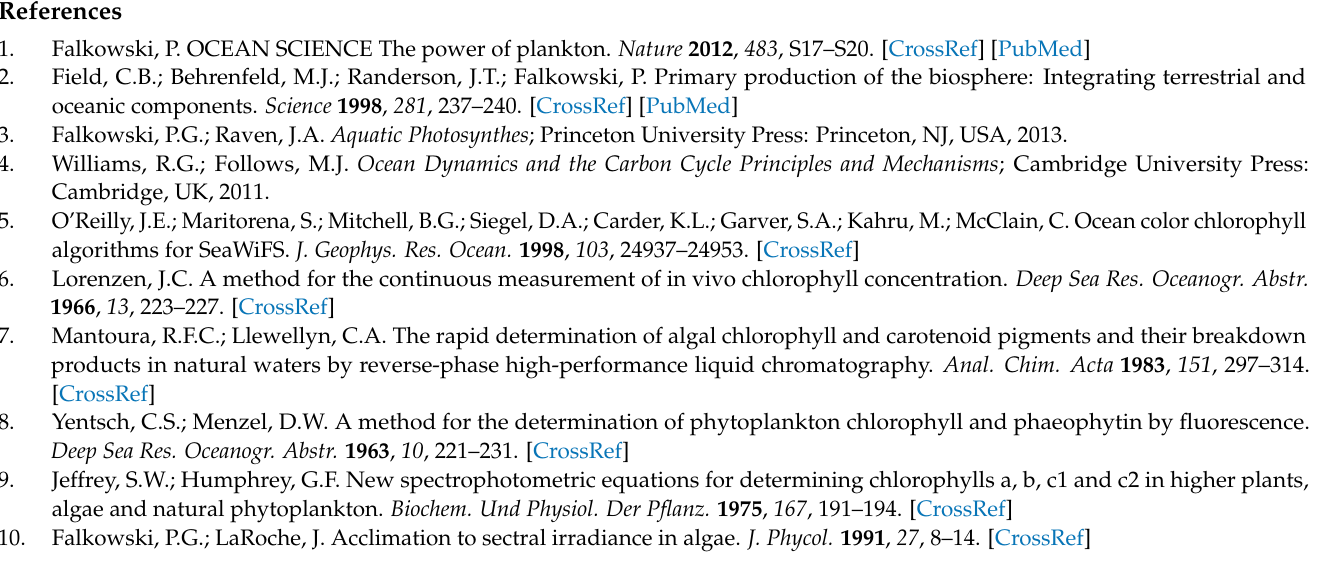
Figure A1. Monthly mean climatological distribution of the chlorophyll a (Chl-a) in the South China Sea (September 1997 to December 2019). The blue line shows the 200-m isobath.